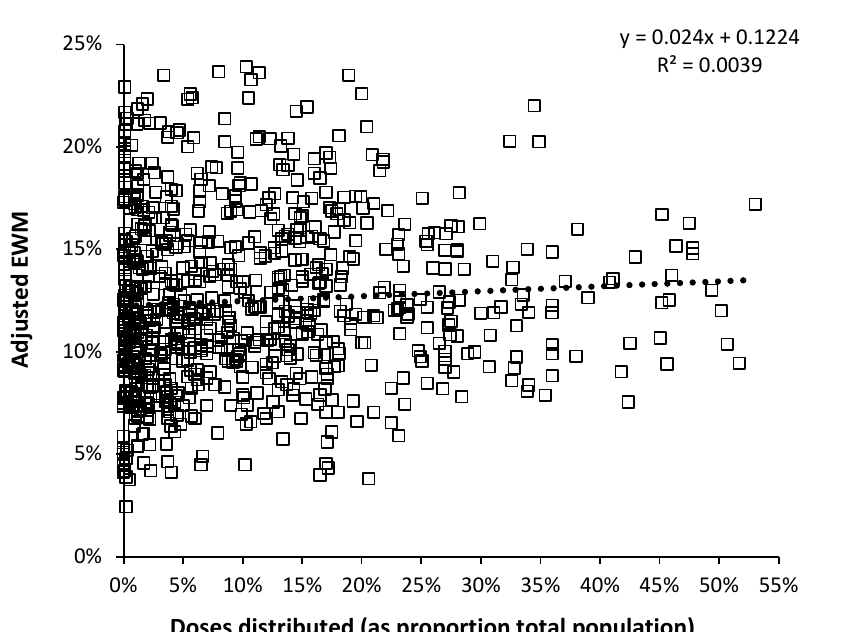
Doses distributed (as proportion total population) Figure A4. Relationship between influenza vaccine doses distributed and adjusted EWM over the winters 1980/81 to 2013/14 (before trimming of high/low values) for a number of northern hemisphere countries. Trimming of high/low values makes little difference (data not shown). Before 2013/14 the bulk of countries lie below 200 doses per 1000 population (20% vaccinated). Dividing the data into three groups of high/medium/low vaccination (17% increments of proportion vaccinated) gives overlapping confidence intervals, and the null hypothesis cannot be excluded. i.e., the slope is zero (data not shown) or no effect can be discerned.